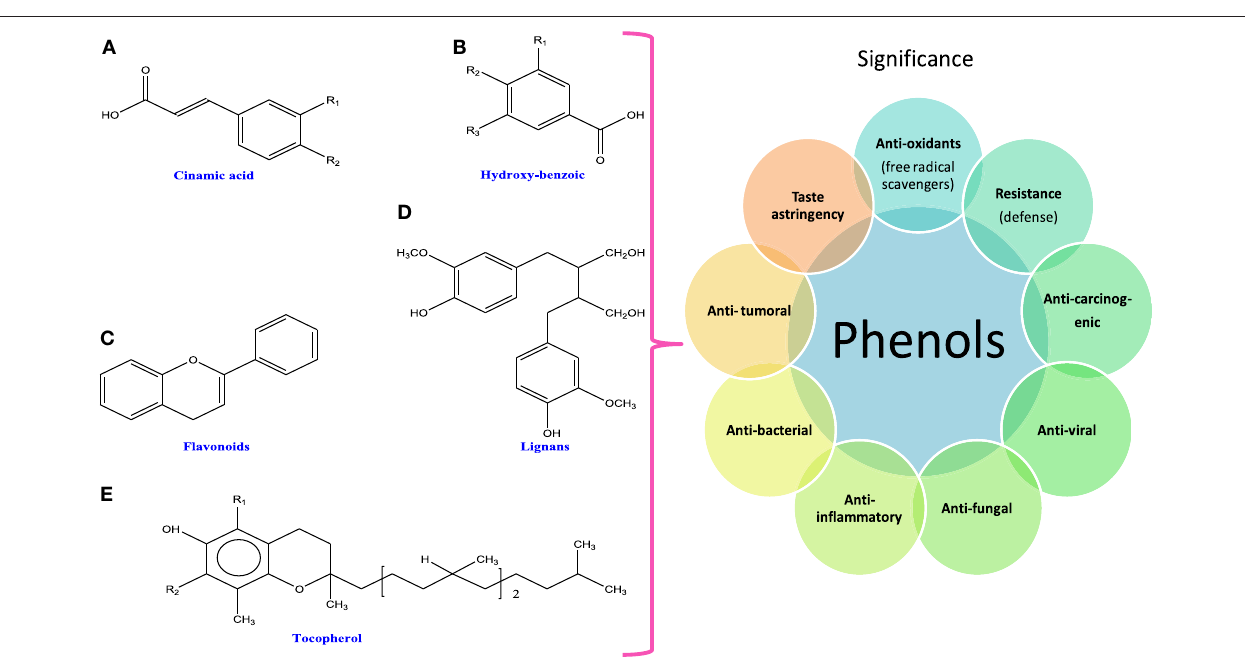
They are also emerging as advanced biofuel precursors like linear terpenes and being practiced to replace the biosynthetic diesel in the global market (Harvey et al., 2010; Pattanaik and